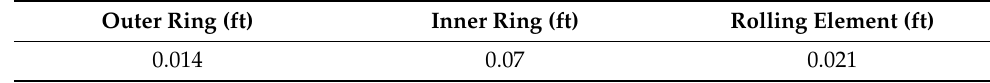
Table 4. Experimental bearing sample attributes.